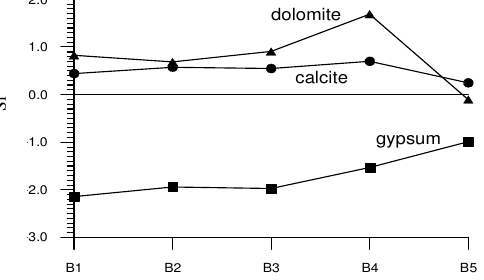
Figure 4. Changes of saturation indices of major minerals along flow path